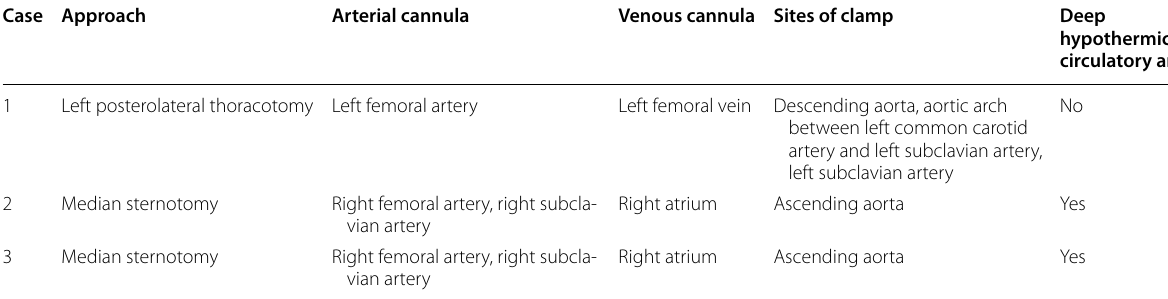
Table 2 Surgical details of three patients with free-floating thrombi